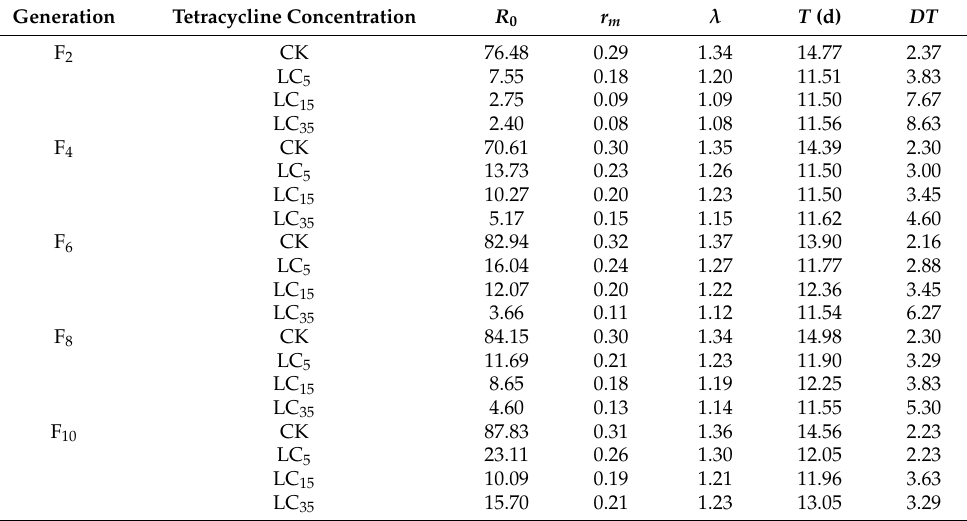
Table 3. Life table parameters of T. pretiosum treatment with sublethal concentrations of tetracycline for ten